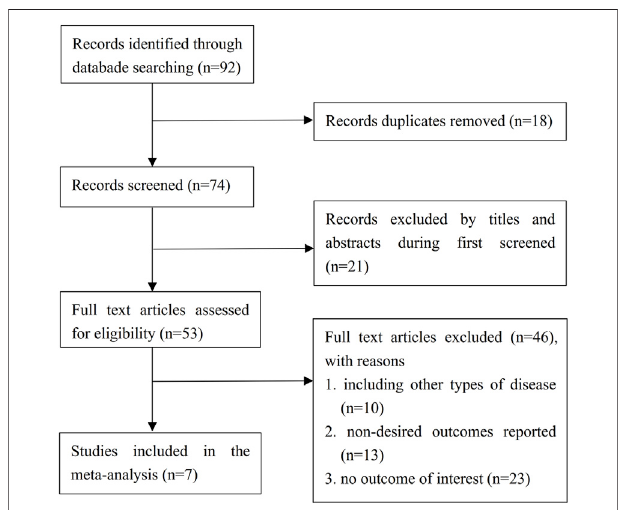
FIGURE 1 | Flow diagram of the literature selection process. RCTs = randomized controlled